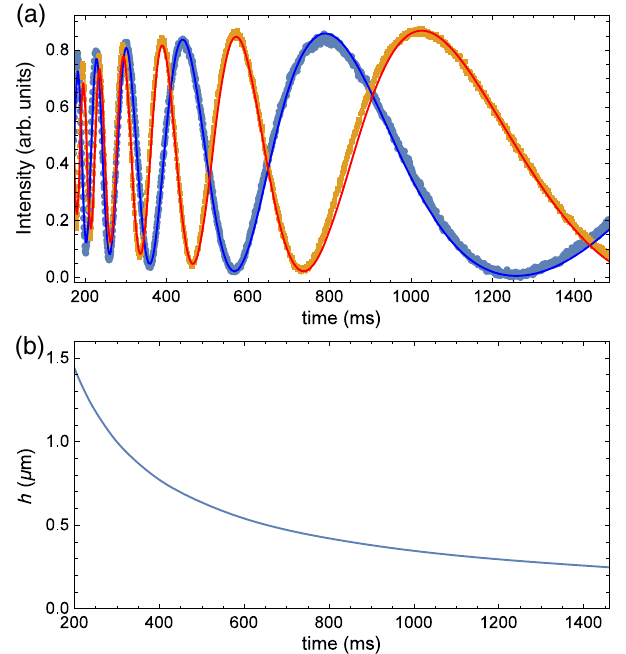
FIG. 6. (a) Measured intensity evolution at the center, i.e., the red line in Fig. 5, for λ ¼ 434 nm (yellow dots) and 546 nm (blue dots), and the corresponding curve fittings (central red and blue curves). (b) Corresponding height evolution at center calculated from (a).